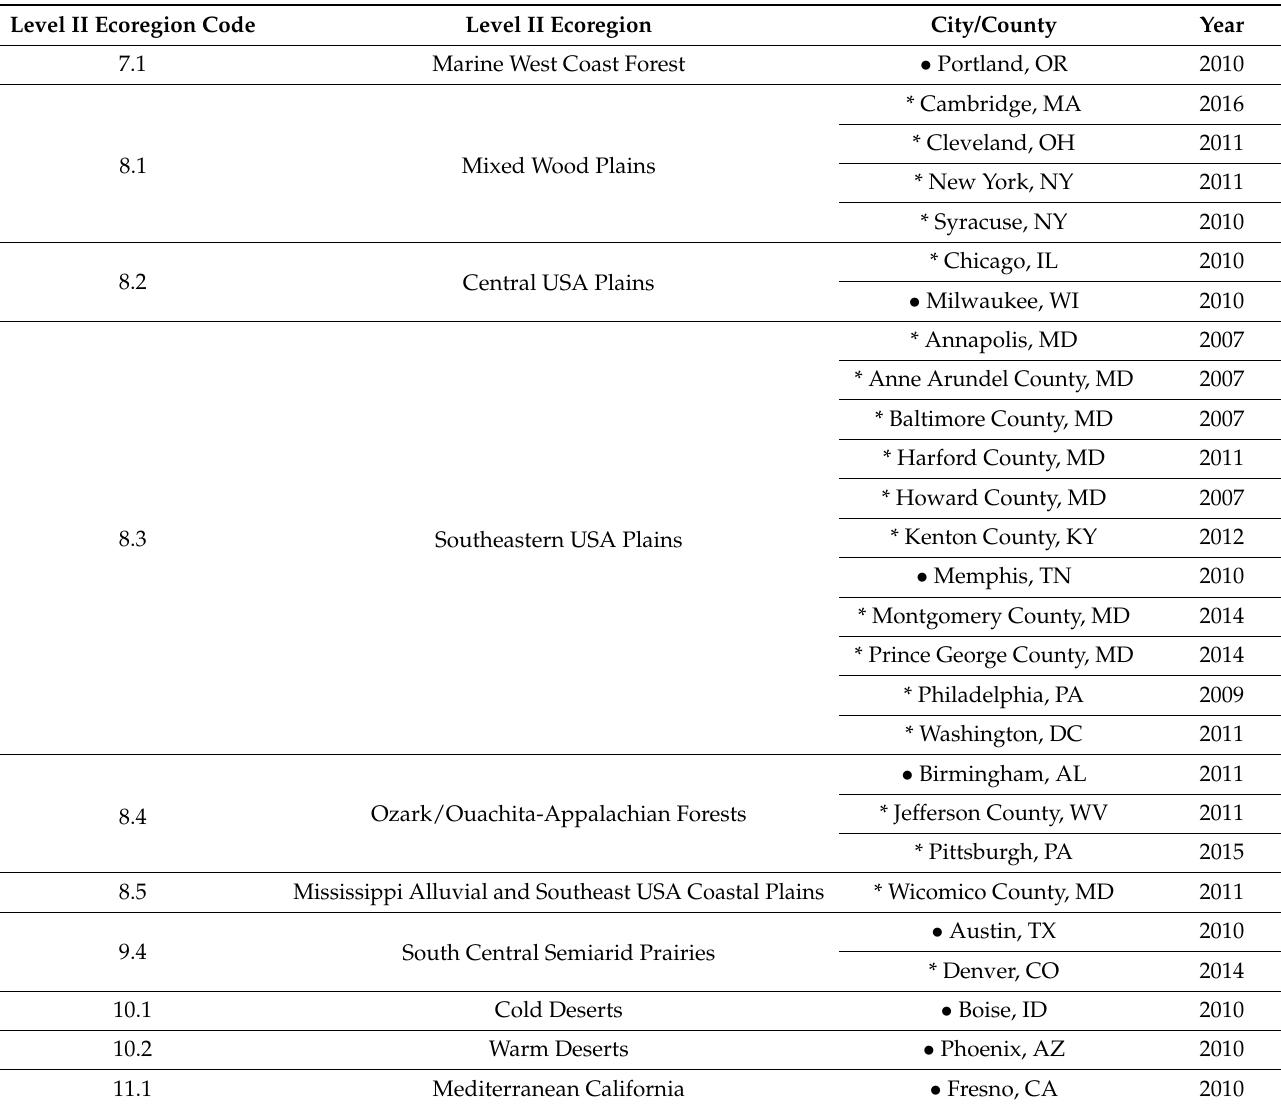
Table 1. Cities with high-resolution (1 m) land cover by US Environmental Protection Agency Level II Ecoregion [28]. City/county data are sourced from either the • US Environmental Protection Agency EnviroAtlas [26] or * the University of Vermont